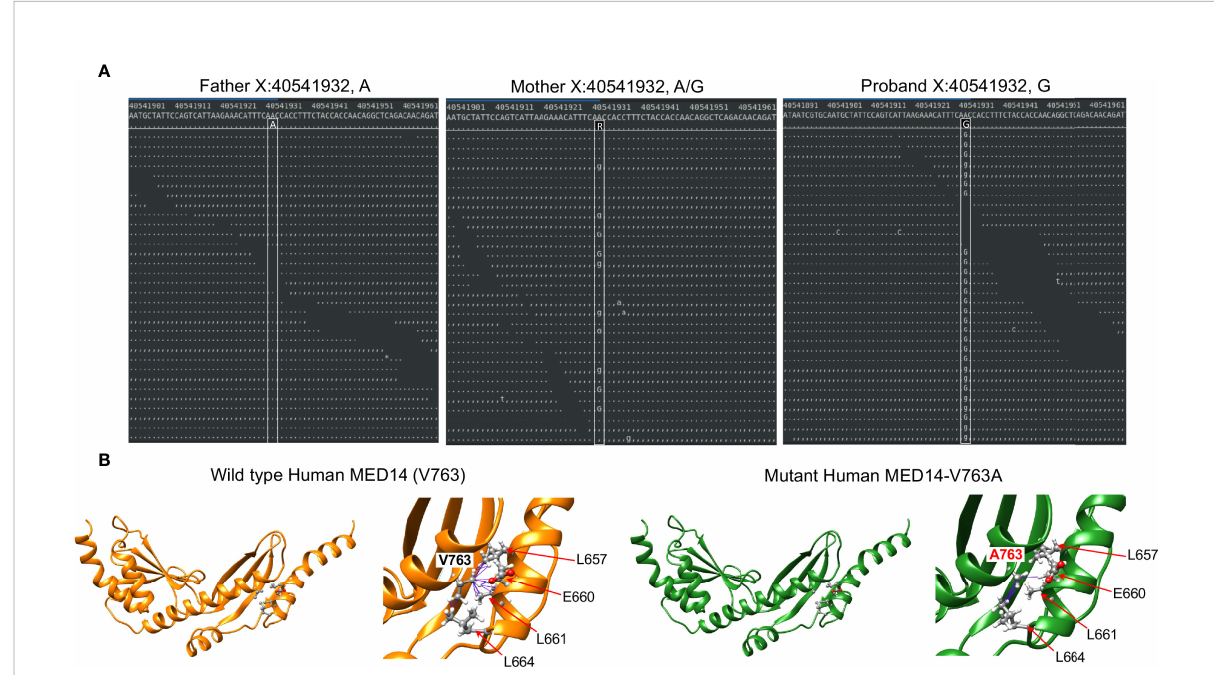
FIGURE 1 Identi fi cation of the MED14 missense mutation by next generation sequencing. (A) Screen shots of NGS sequencing runs of the proband and parents are depicted. The A>G mutation is indicated by upper and lower case G. Dots or commas indicate wild type sequence. (B) Molecular models of the wild type and variant MED14 proteins. Two views of wild type (orange) and V763A mutant (green) human MED14 are depicted. The right half of each panel shows a zoomed in view of aa 763 with nearby residues on the opposing helix that are capable of making contacts with the A or V763. The left panel shows wild type MED14 V763 from known PDB structure 7ENA chain n, residues 637 to 884. The right panel shows the human V763A MED14 variant. Hydrophobic contacts are shown with purple